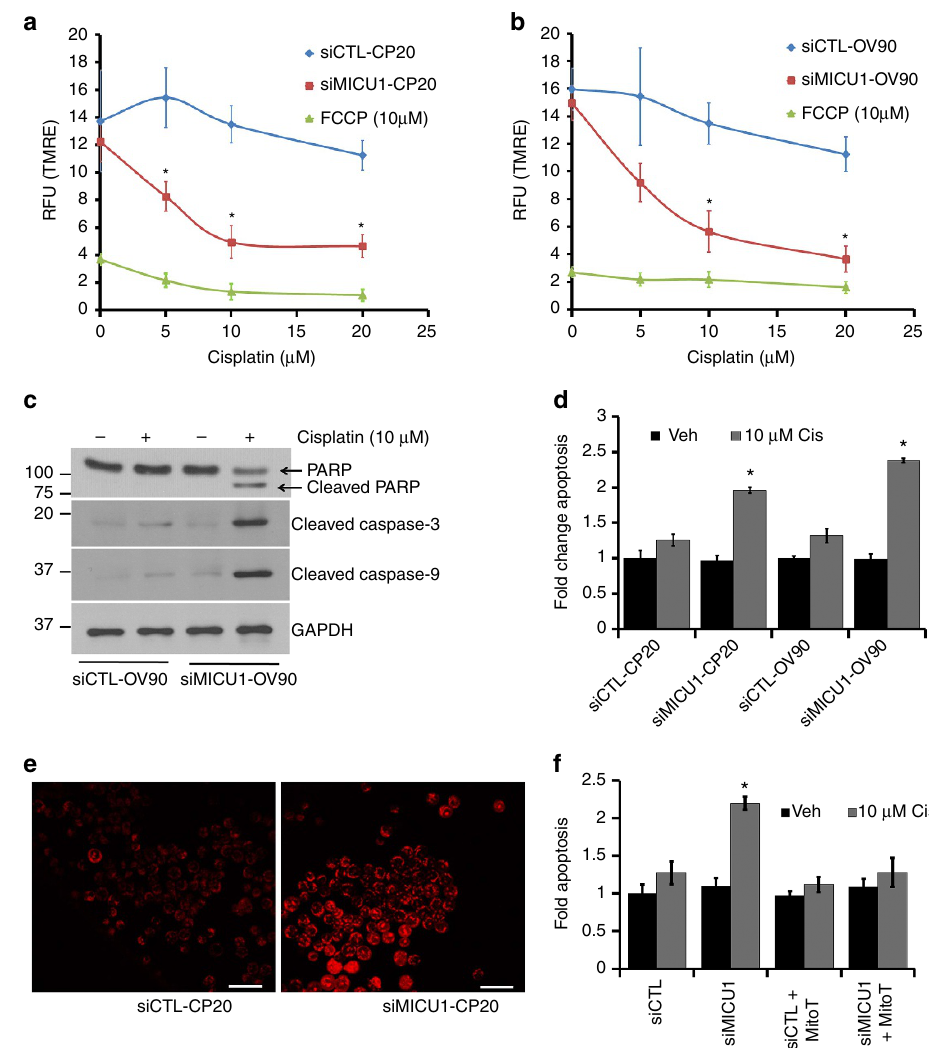
Figure 3 | MICU1 modulates DW m responses and apoptosis in OvCa cells. ( a , b ) In siCTL-/siMICU1-CP20 cells ( a ) and siCTL-/siMICU1-OV90 cells ( b ), loaded with the fluorescent mitochondrial membrane potential ( DC m ) indicator TMRE, cisplatin caused significant membrane depolarization in MICU1 silenced cells compared to respective siCTL cells receiving similar treatment values are represented as mean ± s.d. FCCP was used as a negative control. ( c ) siCTL/siMICU1-OV90 treated or untreated with cisplatin were immuno-probed for apoptotic markers (cleaved PARP, cleaved caspase-3 and cleaved caspase-9). GAPDH was used as a loading control. ( d ) Quantification of apoptotic cell number in CP20 and OV90 cells upon cisplatin treatment (10 m M). Silencing MICU1 sensitized cells to cisplatin-induced apoptosis and values are mean ± s.d. ( e ) siCTL-/siMICU1-CP20 cells grown on coverslips were incubated with mtROS detecting agent MitoSOX (5 m M) and then imaged. ( f ) mtROS contributes to cisplatin sensitization in MICU1 silenced cells. Cisplatin (10 m M) treatment in CP20 cells in presence of mtROS scavenger MitoTempo (10 m M) failed significantly to induce apoptosis in siCTL- or siMICU1-CP20 cells and values are represented as mean ± s.d. * P o 0.05 when compared to siCTL ( a , b ) or vehicle ( d , f ). Two-sided Student’s t -test was used for statistical analysis with unequal variances. Statistical significance was set at P o 0.05. All the experiments were repeated independently at least three times and in